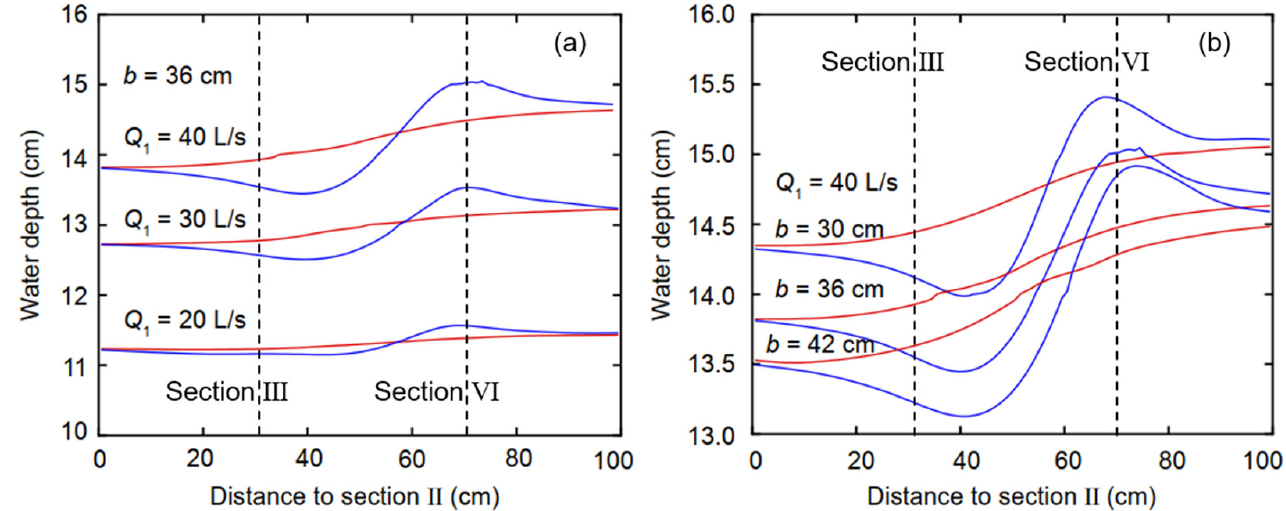
Figure 4. Water depth change along the direction of water flow in trapezoidal open channel for ( a ) variation in flow discharge and ( b ) variation in branch channel width. Note: Red lines indicate the water depth on the line y = 64 cm, blue lines indicate the water depth on the line y = 94 cm.